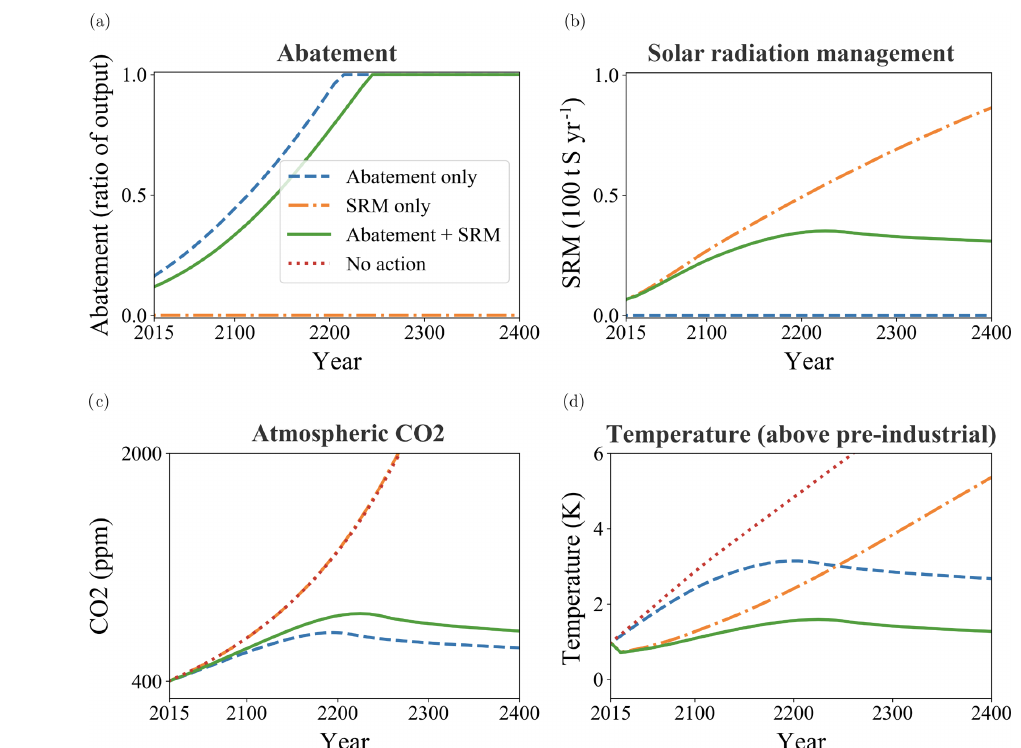
Figure 2. Optimal policy and climate model results for the three stylised scenarios in the deterministic setting. (a) Abatement (fraction of CO 2 emissions avoided), (b) SRM (Mt(S)yr − 1 ), (c) atmospheric CO 2 concentration (ppmv), and (d) global mean temperature above pre-industrial temperature (K). The dashed blue line represents the abatement-only scenario, dashed-dotted orange line represents SRM-only scenario, solid green line represents abatement+SRM scenario, and dotted red line (only panel c and d ) represents no climate action (i.e. neither abatement nor SRM). Table 2. Comparison of policies in the deterministic setting (no tipping, no SRM failure). abatement-only scenario means that no SRM is used, SRM-only scenario means that no abatement is used (unless SRM fails see text), and in abatement+SRM scenario both are used. The performance ζ (see Eq. 13) is a measure of the increase in expected cumulated discounted utility w.r.t. the no-action scenario, and is normalised such as to yield 100% for abatement-only scenario. The column “Peak SRM” contains the highest SRM values (in Mt(S)yr − 1 ) over all time steps. “Ab 50%” and “Ab 99%” show the year in which the abatement reaches 50% and 99%, respectively. SCC is the social cost of carbon in the first time step (measured in USD (in 2005) per tonne of carbon). Policy ζ Peak SRM Ab. 50% Ab. 99% SCC Abatement-only scenario 100% n/a 2114 2212 35 SRM-only scenario 186% ∗ n/a n/a 21 Abatement+SRM scenario 238% 35.1 2134